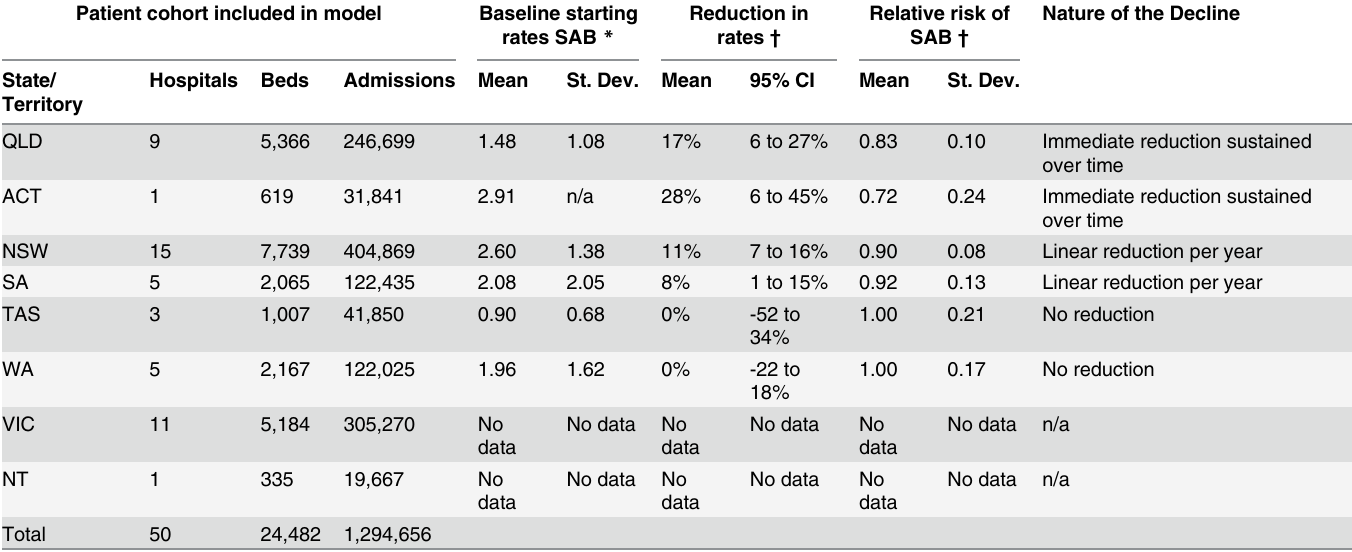
QLD = Queensland, ACT = Australian Capital Territory, NSW = New South Wales, SA = South Australia, TAS = Tasmania, WA = Western Australia, VIC = Victoria, NT = Northern